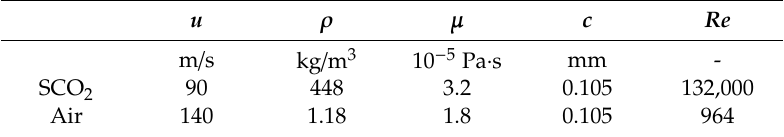
Table 2. Re number at the second sealing teeth of SCO 2 and air as working fluid.